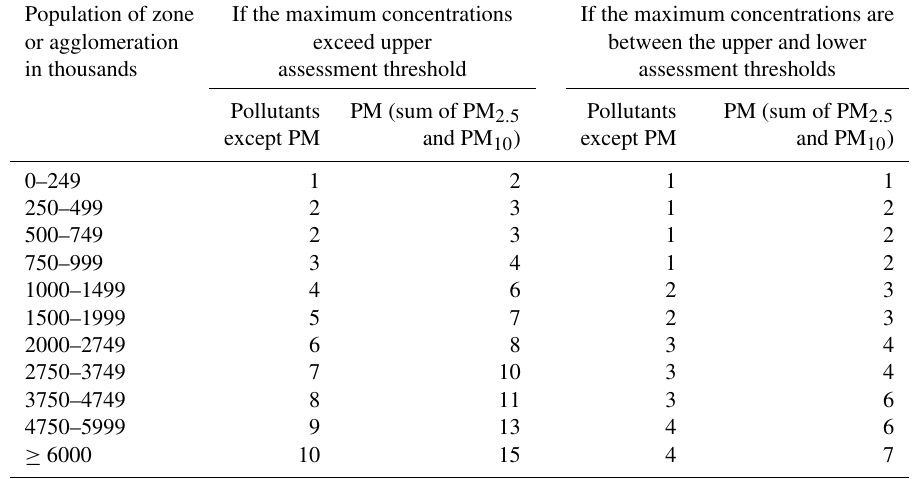
Table 2. Minimum number of sampling points per zone or agglomerate as a function of population (European Council, 2008). Population of zone If the maximum concentrations If the maximum concentrations are or agglomeration exceed upper between the upper and lower in thousands assessment threshold assessment thresholds Pollutants PM (sum of PM 2 . 5 Pollutants PM (sum of PM 2 . 5 except PM and PM 10 ) except PM and PM 10 ) 1 2